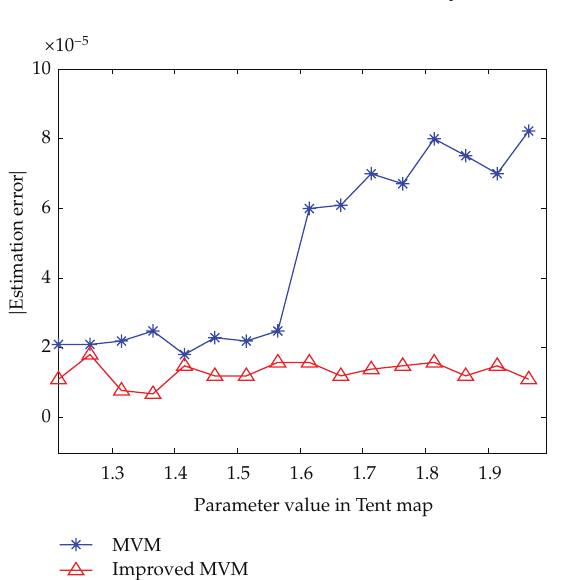
Figure 7: The estimation error of MVM in (cid:5) 8 (cid:6) and the improved MVM proposed in this paper for Tent